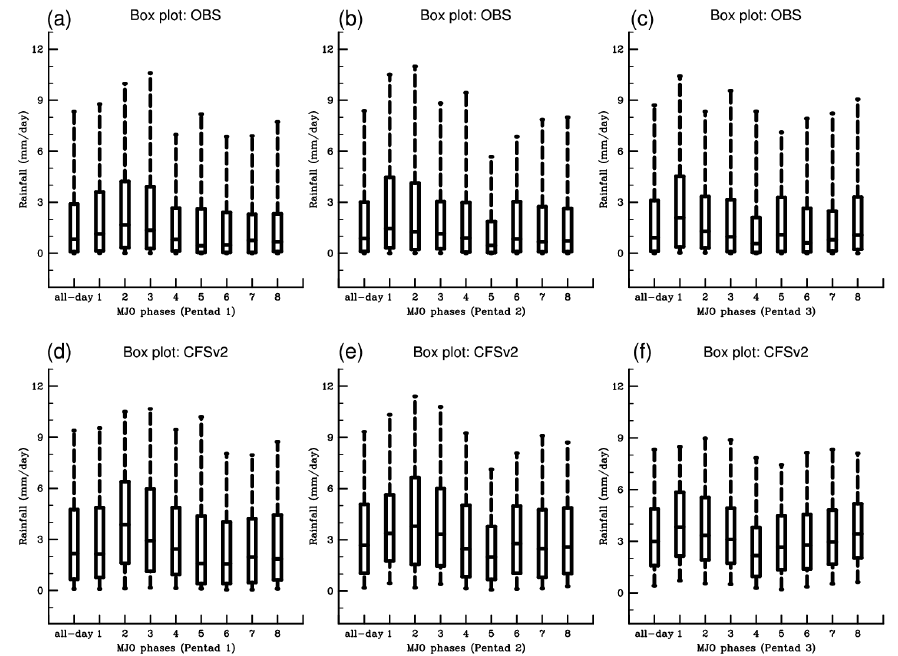
Figure 8. PDFs of rainfall in southern China when initialized from MJO phases 1–8 and all days (NDJFM) at forecast pentad 1 (left), pentad 2 (middle), and pentad 3 (right), where the upper row ( a – c ) for observations and the bottom row ( d – f ) for CFSv2.